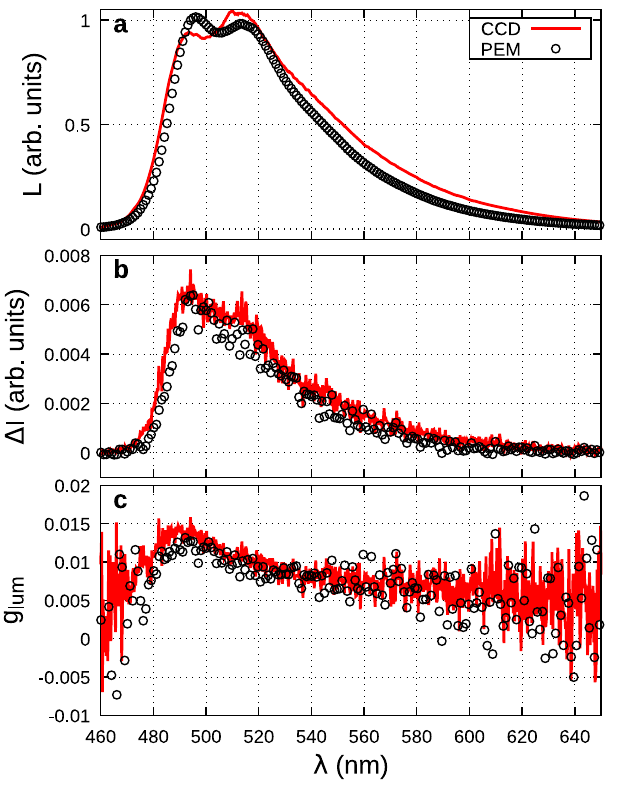
Fig. 3 | CPL of camphorquinone. Luminescence ( a ), CPL ( b ), and g lum ( c ) of (+) -1 under 450nm excitation. The scales luminescence and CPL are normalized to the maximum emission. In red the spectra were recorded with the CCD camera using the four signals procedure, in the black circle the spectra were recorded in a step- by-step setup using a PEM+analyser system. Wavelength response correction has been applied for each system.